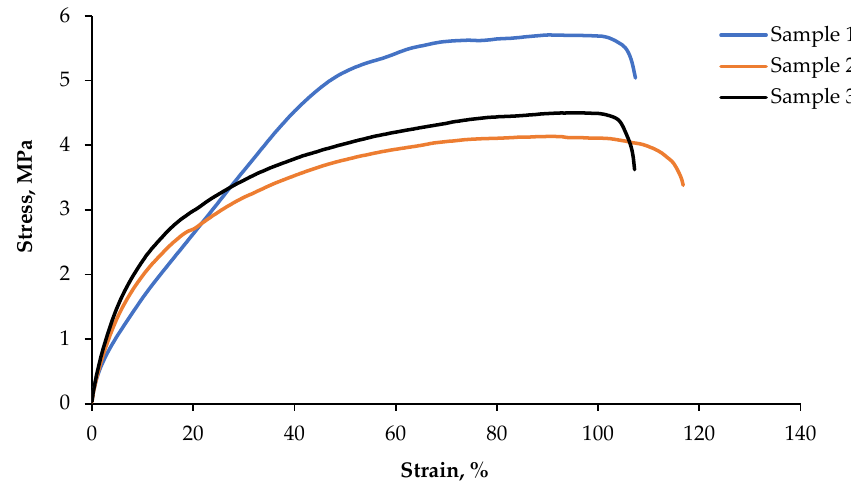
Table 4. Results of measurements and calculations of impact strength according to Charpy.